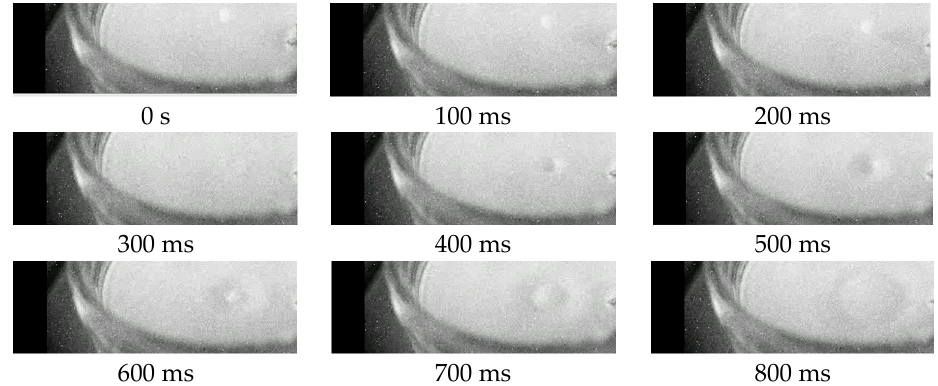
Figure 18. Sequence of a drop fall recorded at 1200 fps; the frame-to-frame time interval shown in the sequence was 100 ms.